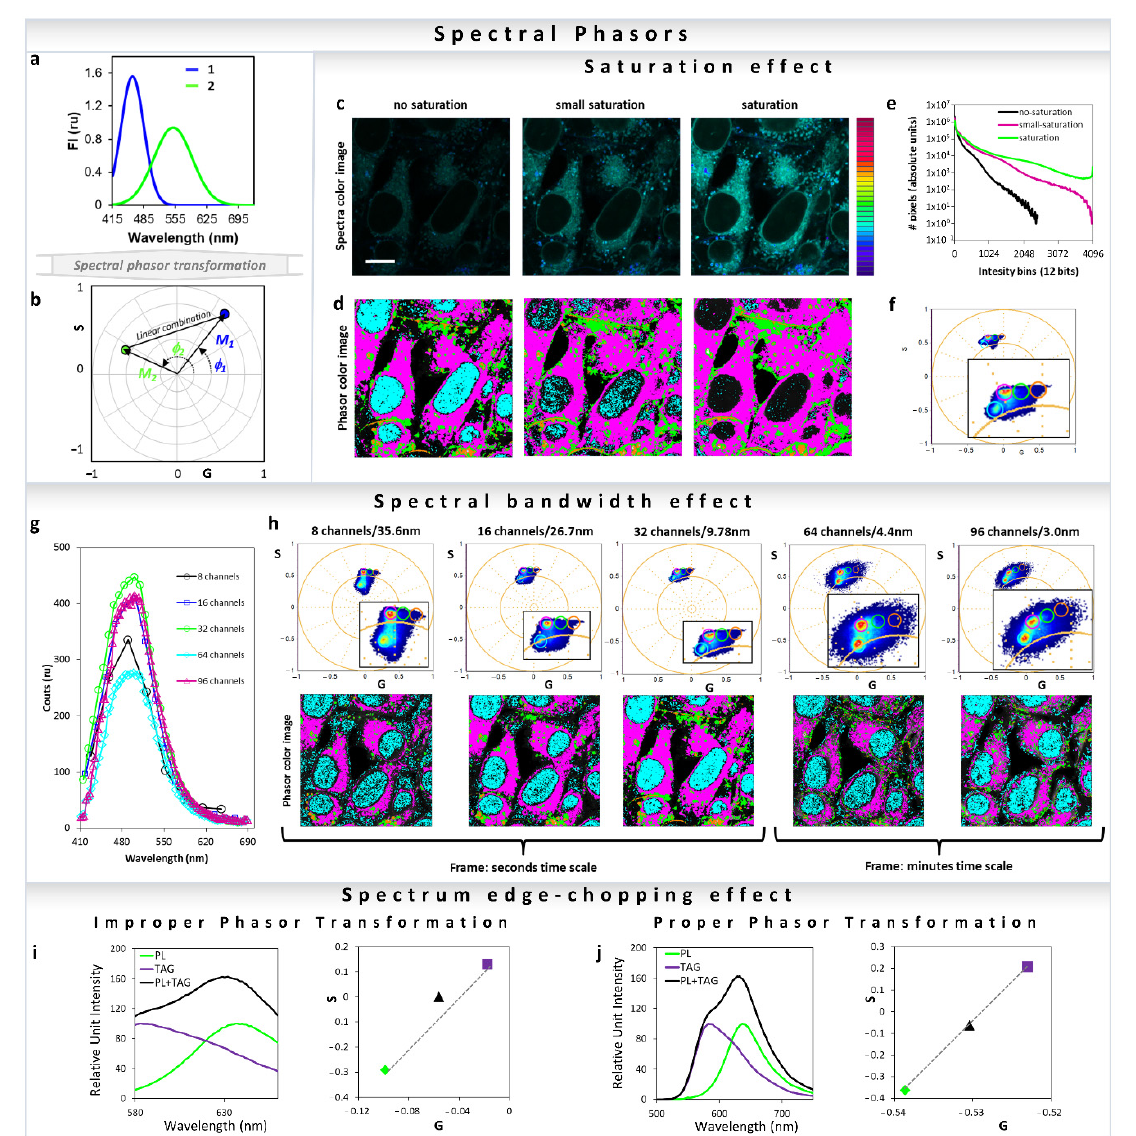
Figure 13. Spectral phasor transformation properties and important considerations. ( a , b ) Simulation of two gaussian curves with different centers of mass and FWHM ( a ), and the transformation into the spectral phasor plot ( b ). Note that while the blue curve has a longer M and short Φ (meaning bluer and narrow spectra), the green curve has a shorter M and larger Φ (meaning greener and broader spectra). The line that joins the two components represents the linear combination for all the different fractions between component 1 and 2. ( c – f ) Effect of the spectral saturation on the spectral phasor transformation. ( c ) Spectral and ( d ) pseudo-color images of HeLa cells stained with ACDAN (5 μ M final concentration), imaged at different laser powers (with increasing saturation from left to right). Scale bar 10 μ m. ( e ) The corresponding intensity histograms. ( f ) Based on a set of cursors in the phasor plot for the no-saturation condition, the effect of saturation and changes in the location of the phasor cloud by aberrant transformation can be seen. The phasor plot consists of the clouds from the three images (no-saturation, small-saturation, saturation). ( g , h ) Effect of the spectral bandwidth on the spectral phasor transformation. ( g ) The average spectra of the pixels from each image are shown here (8, 16, 32, 64 and 96 channels, respectively). Note that counts were kept in a similar range for comparison purposes. The data were acquired using a 32-channel spectral on the Zeiss LSM 710, therefore by default it records spectra using 32 parallel channels. Note that increasing resolution (increasing number of channels and decreasing the bandwidth per channel) of the phasor transformation results in a broader cloud (due to the poorer S/N per channel). The second noticeable difference is the time it takes to acquire the image due to the wavelength scanning needed for higher resolutions. Analyzing the image quality for the different configurations, it is simple to note that 32